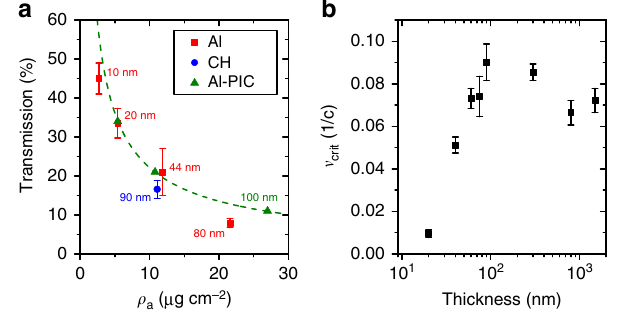
Fig. 4 Measurements of laser light transmission and target critical surface velocity. a Percentage of laser light transmitted as a function of target areal density ( ρ a ) for stated thicknesses ( ‘ ), for plastic (blue; CH) and Al (red) foils. The error bars are determined from the uncertainties in the calibration of the light level on the transmission screen and the area of the transmitted beam sampled. Results from the 2D PIC simulations with Al foils (green; Al- PIC) are included. b Recession velocity of the critical density surface ( v crit ) as a function of ‘ for plastic targets, as determined from measurements of spectral shift in second harmonic light produced at the critical density surface. The lower and upper limits of the error bars are determined from the maximum red-shifted wavelength, where the signal is resolvable above the noise level and by application of a fi tting routine, respectively